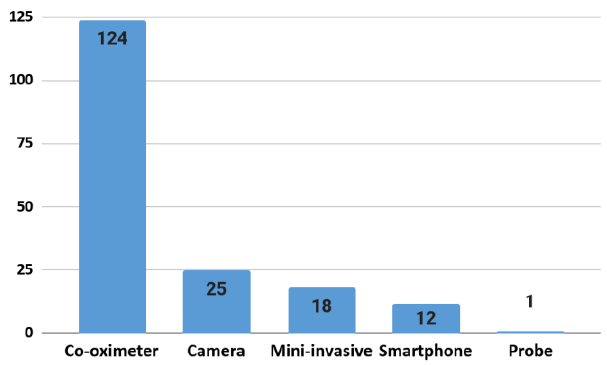
Figure 6. Distribution of papers by device for the assessment. Table 4. Device types’ definitions.